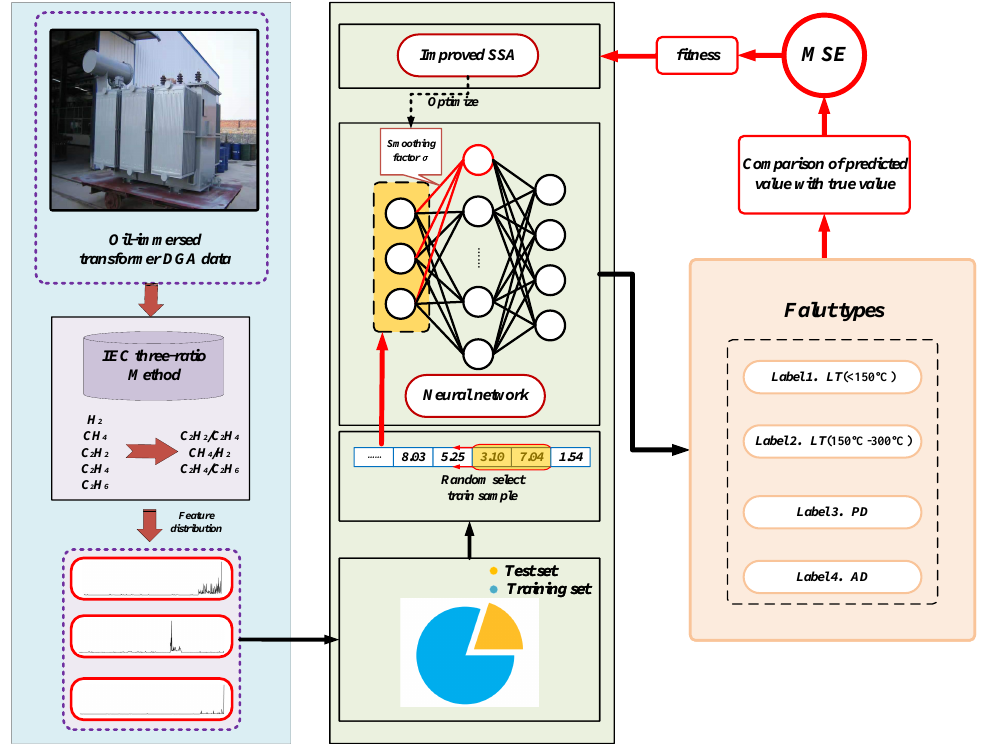
Figure 3. The implemented framework of the power transformer fault